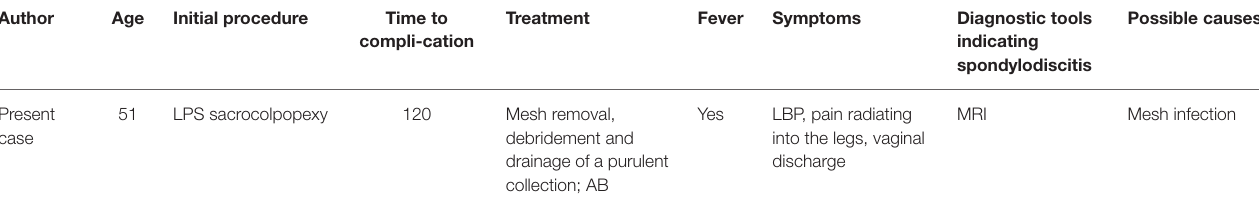
TABLE 1 | Data of present case.